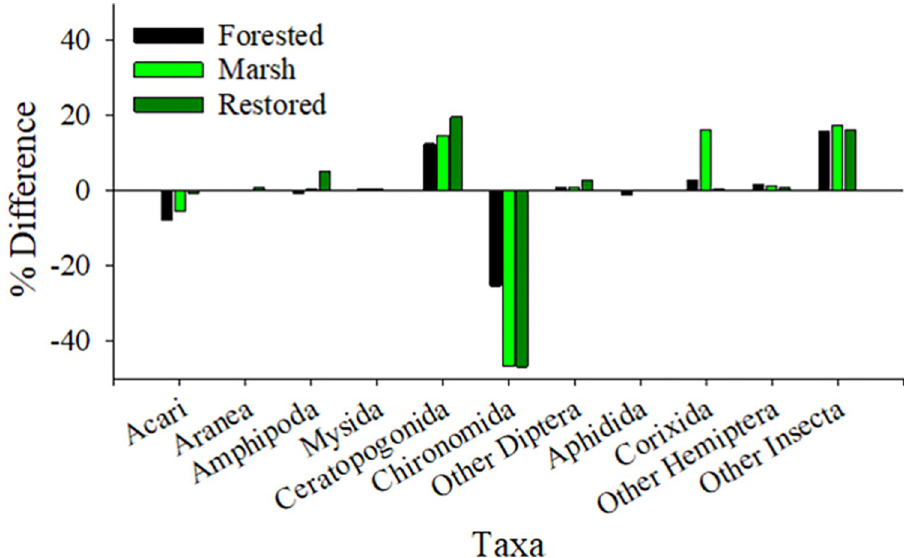
Fig 7. Taxa contributions to energy transport, relative to a mean proportional transport, by habitat type. Samples were pooled within the May to June 2017